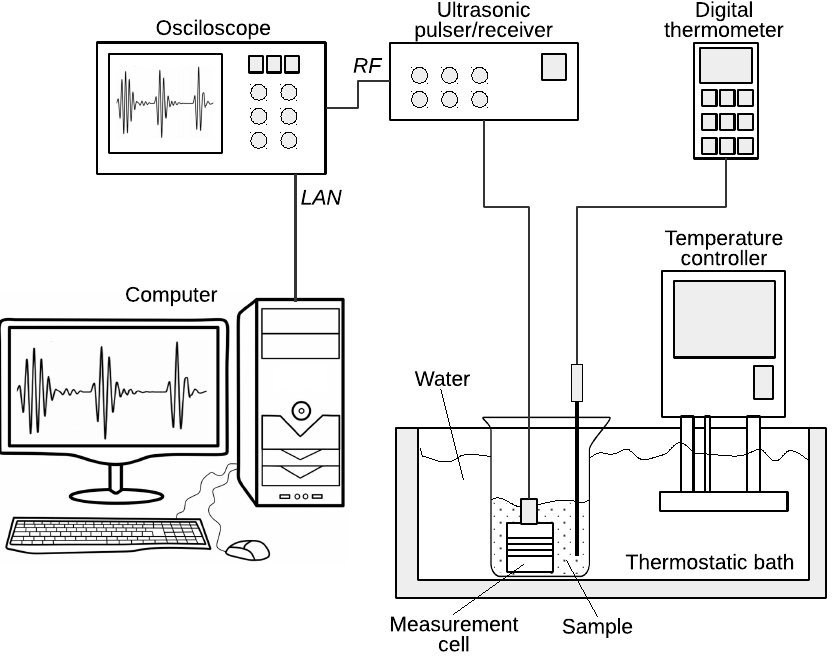
Figure 2. The measurement setup